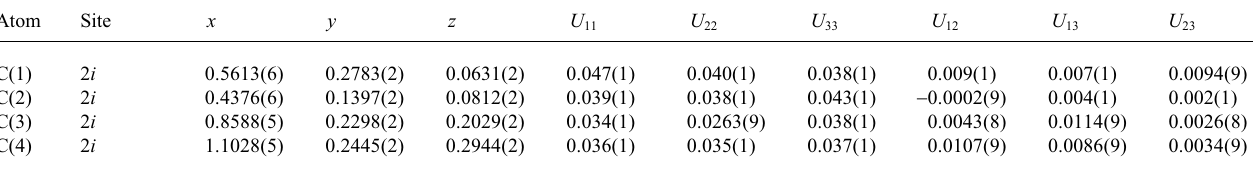
Table 3. Atomic coordinates and displacement parameters (in Å 2